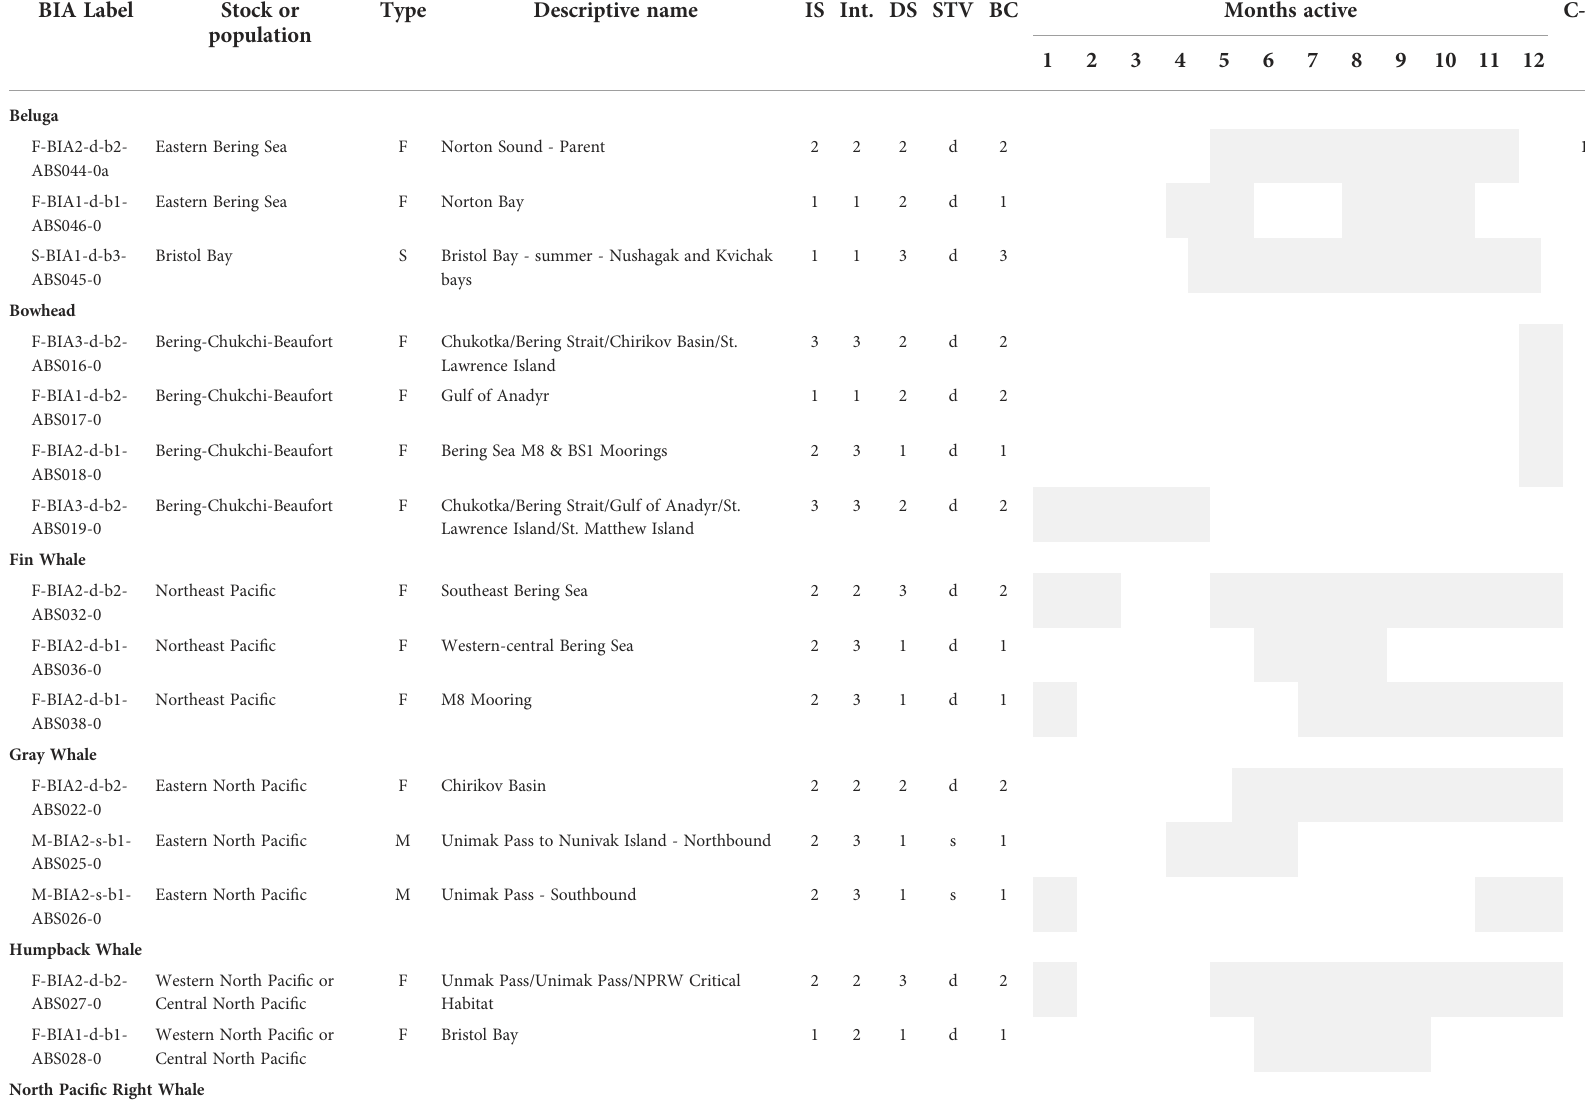
TABLE 3 Aleutian Island and Bering Sea region BIAs by species and BIA type, with general locations, scores, and designated months. BIA